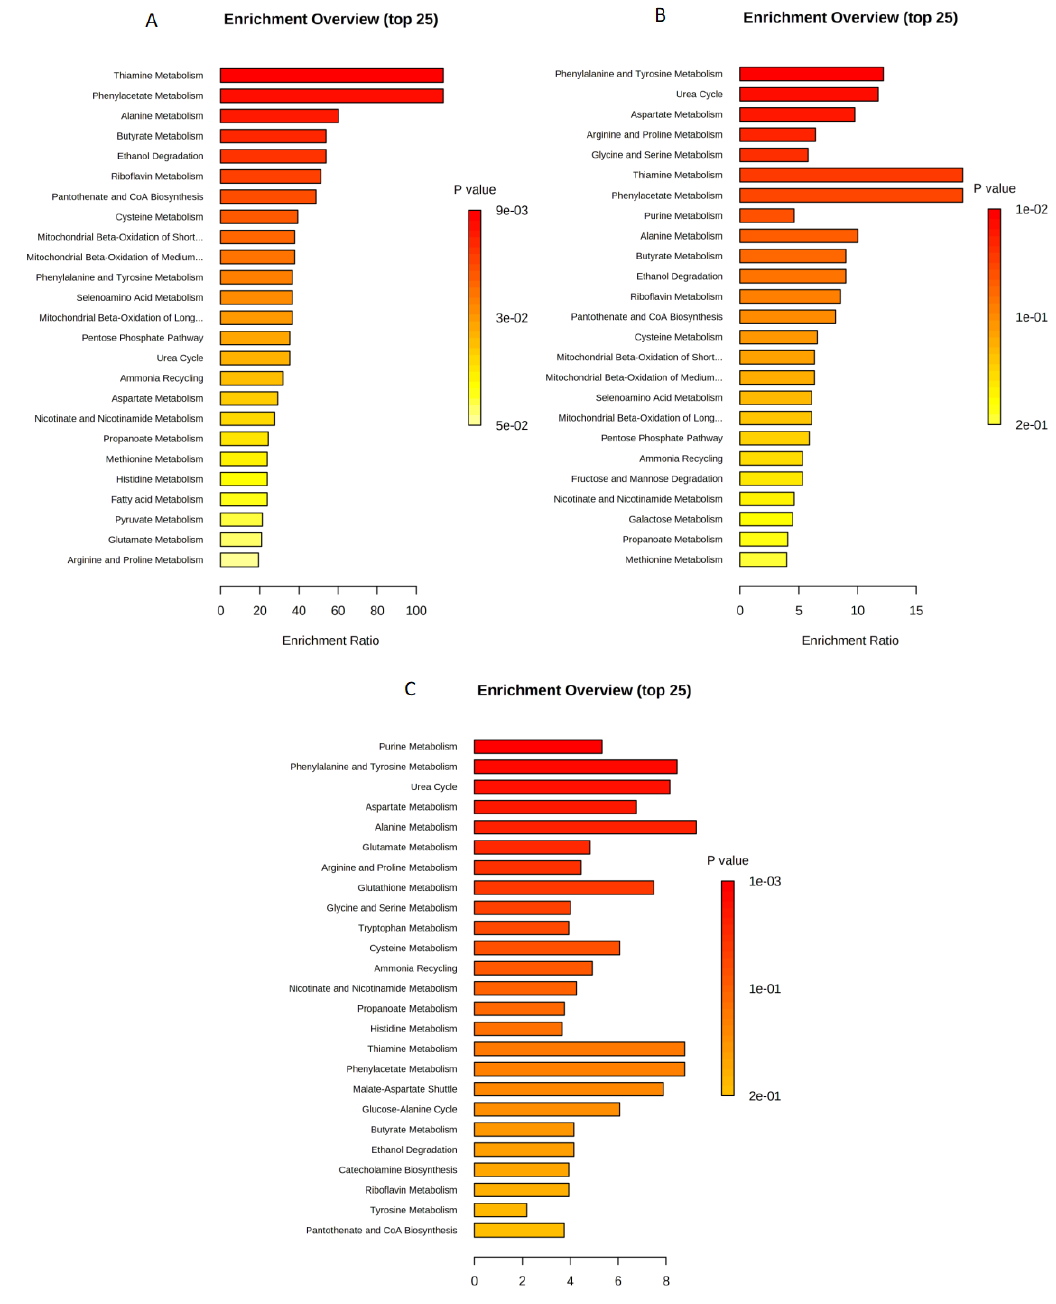
Figure 6. Enrichment analysis for ( A ) DMSO with paclitaxel 4.2 nM; ( B ) DMSO with etoposide 10 µg/mL; ( C ) DMSO with (paclitaxel 4.2 nM + etoposide 10 µg/mL) in U373 cell line.